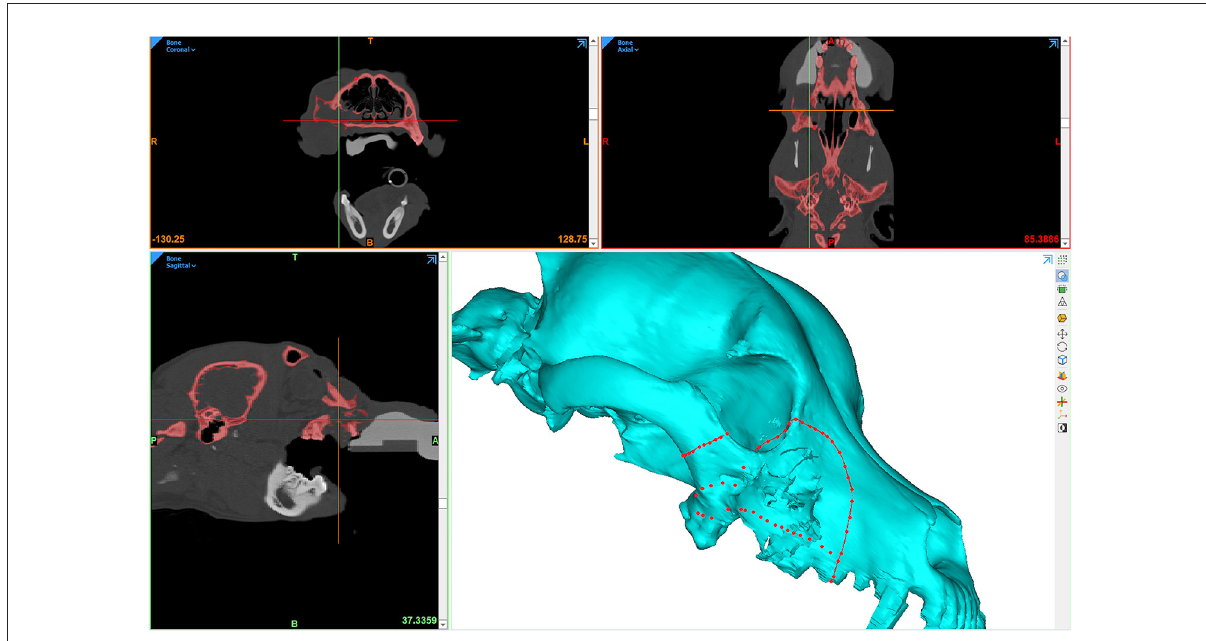
FIGURE5 Computer screenshot depicting VSP in a patient with a caudal maxillary neoplasm. The red lines depict intended surgical margins, which are used to create virtual